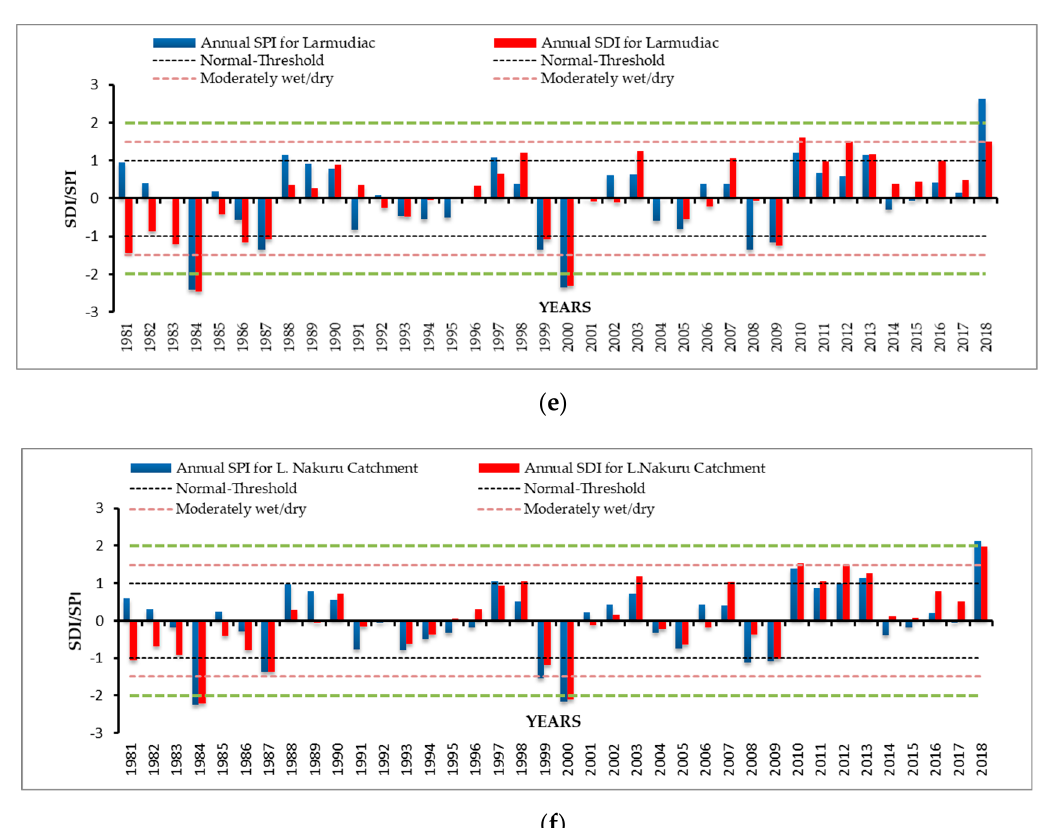
Figure 12. Changes in annual SPI and SDI index (12–month timescale) for Lake Nakuru catchment from 1981 to 2018 for Njoro ( a ), Ngosur ( b ), Nderit ( c ), Makalia ( d ), Larmudiac ( e ), and Lake Nakuru ( f ) subcatchments. Table 8. Distribution of wet and dry periods for 12-month SDI and SPI for Lake Nakuru subcatchments and the entire catchment.